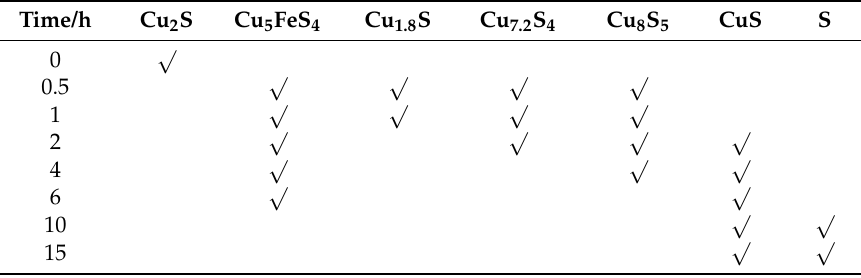
Figure 3. SRXRD results of the phase transformation process in the first stage of chalcocite acidic ferric sulfate leaching (Shanghai Synchrotron Radiation Facility (SSRF)). Table 2. The minerals detected in different leaching time. Table 2. The minerals detected in different leaching time.